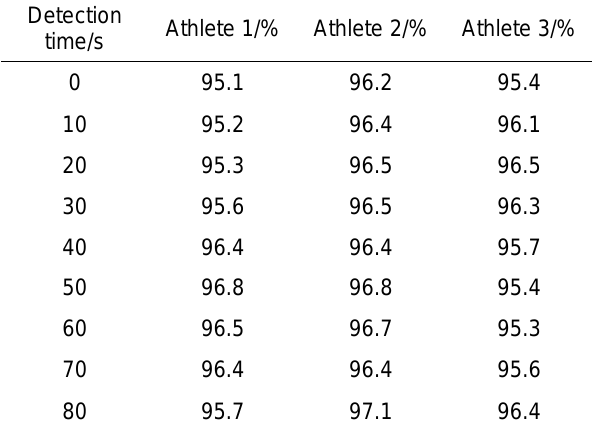
Table 3. Changes in blood oxygen